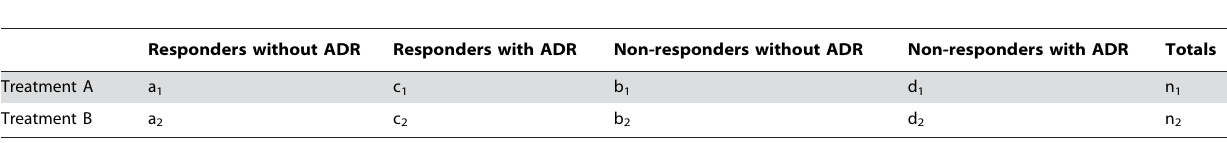
Responders without ADR